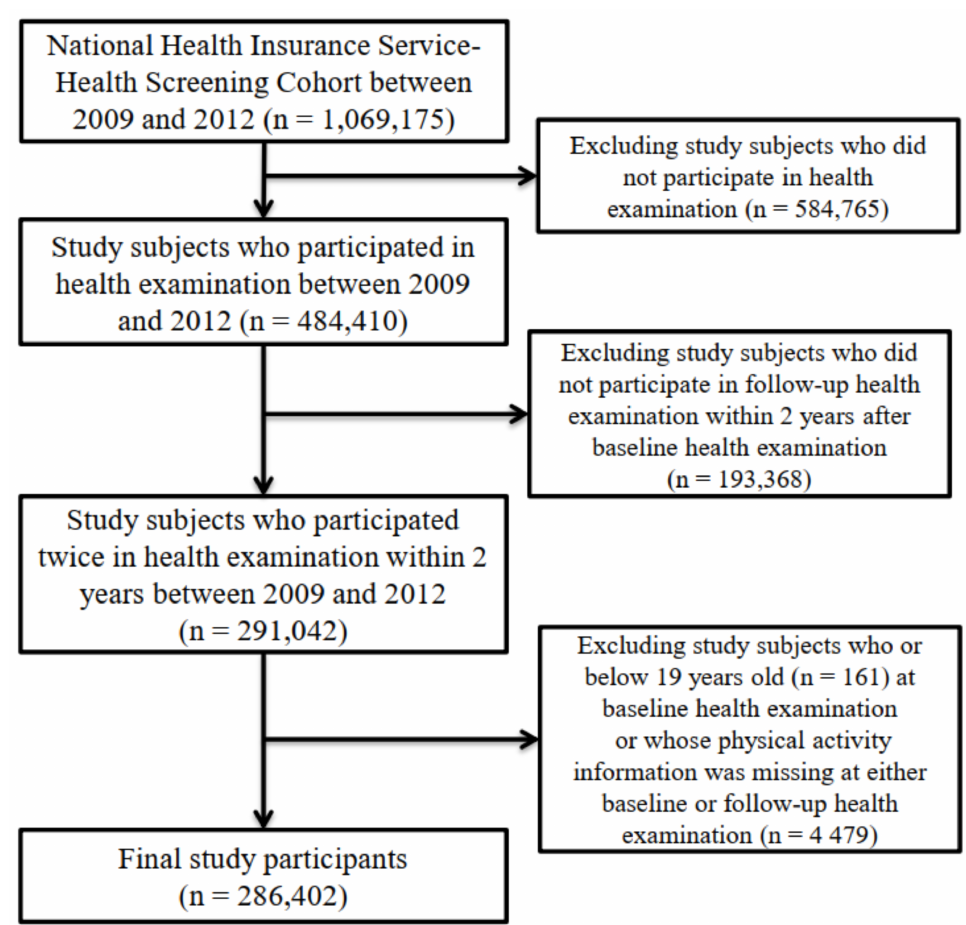
Figure 1. Flow chart of the study